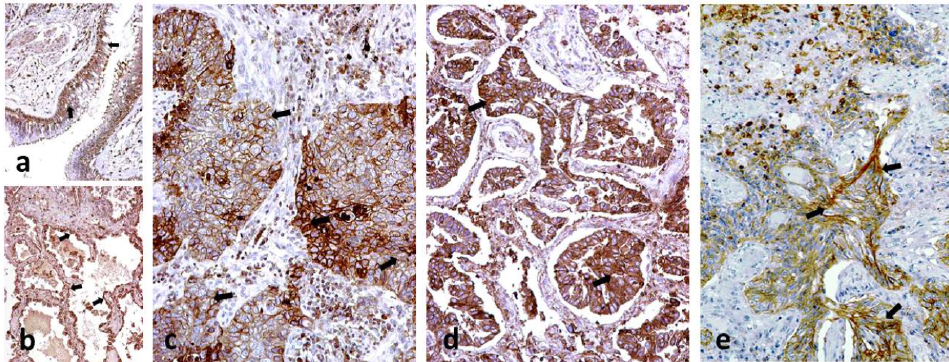
Figure 1. Immunhistochemistry for CD47: ( a ) CD47 immunostaining of normal bronchial epithelium (arrows); ( b ) CD47 immunostaining by alveolar epithelium (arrows); ( c ) Strong staining of CD47 expressed by the cellular membranes of cancer cells (arrows) in a squamous cell carcinoma of the lung; ( d ) Strong staining of CD47 expressed by the cellular membranes of cancer cells in lung adenocarcinoma (arrows); ( e ) CD47 expression by stroma fibroblasts (arrows) in the context of lack of CD47 expression by cancer cells; All images are shown at × 20